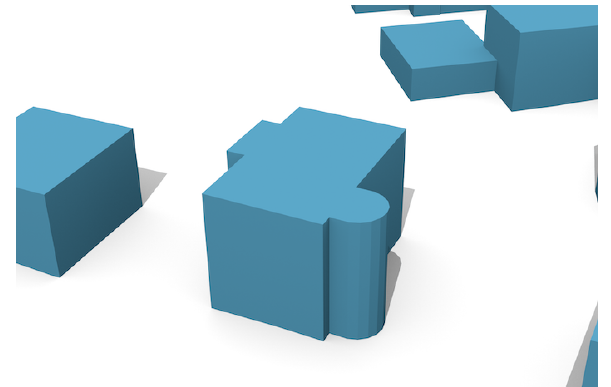
Figure 11. LoD1 counterpart of the LoD2 building exemplified in Table 1. The multiplicity of roofs within the same footprint might hamper future